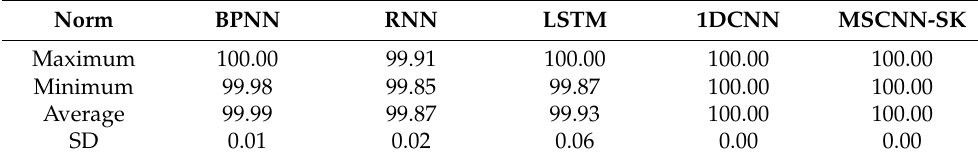
Table 4. Shallen–Key band-pass filter circuit fault diagnosis comparative experiment.